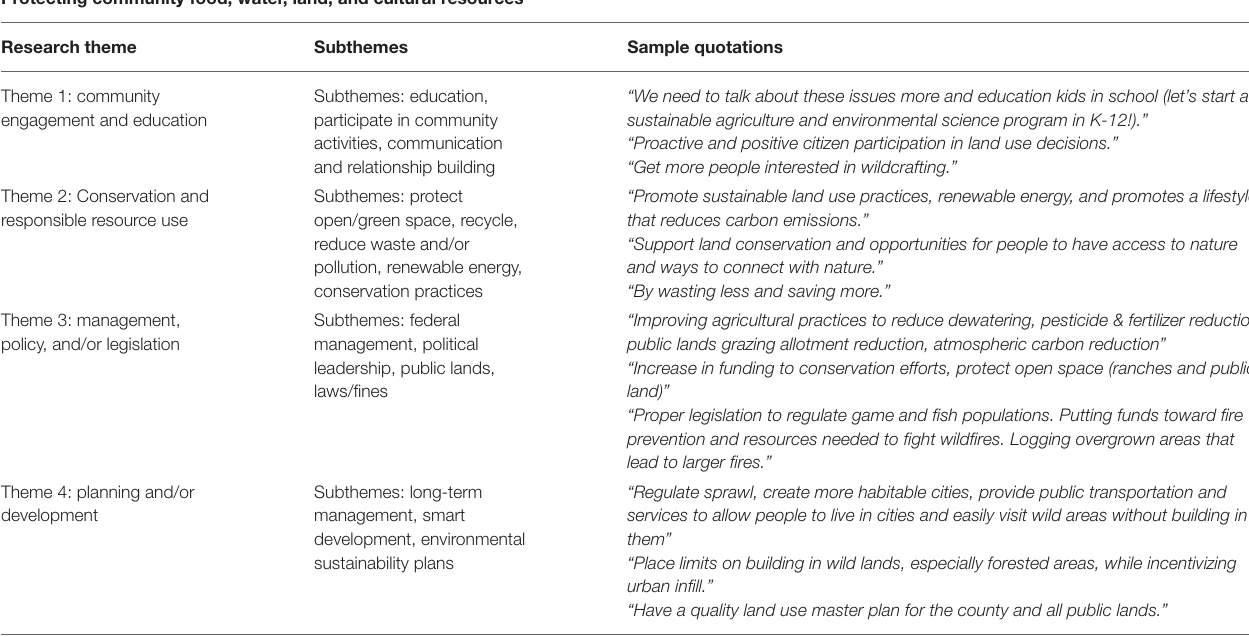
TABLE 4 | Protecting community food, water, land, and cultural resources. Protecting community food, water, land, and cultural